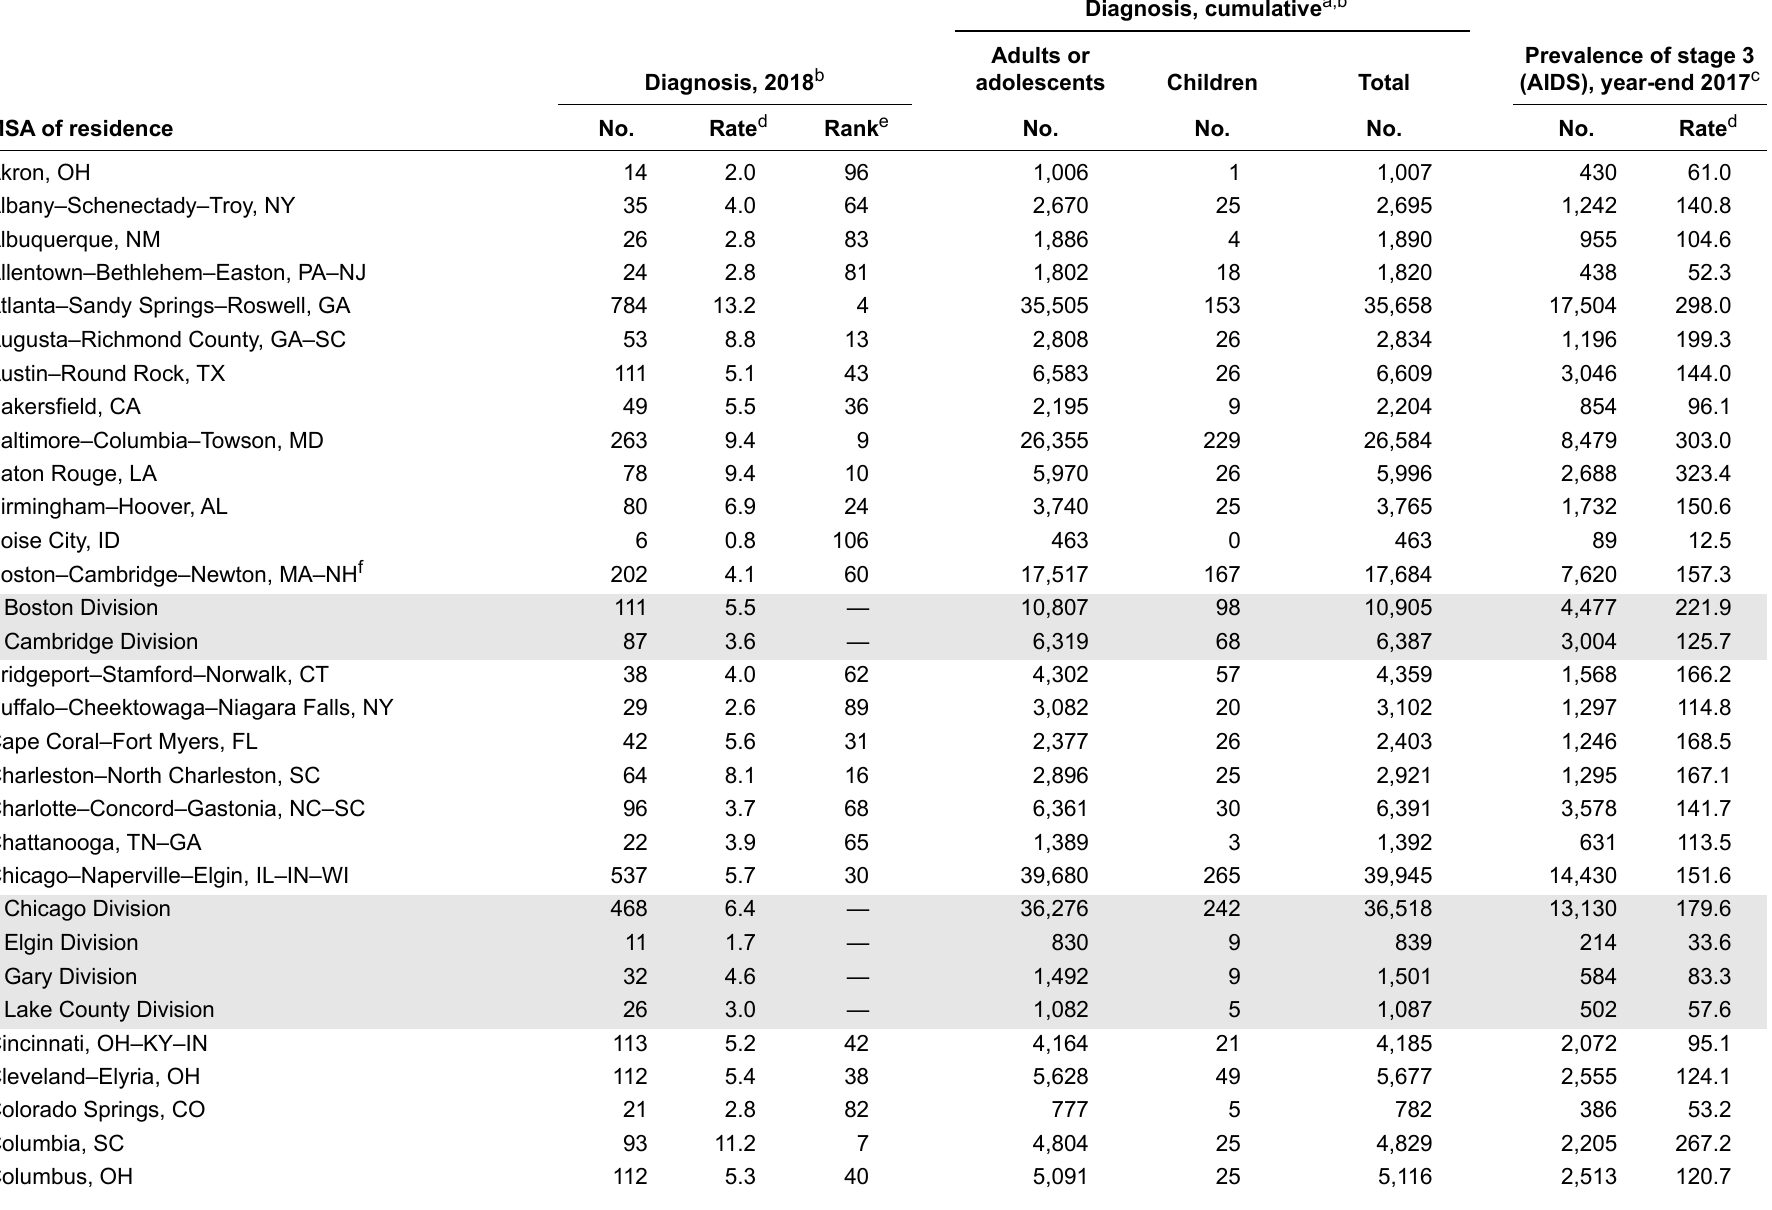
Table 31. Stage 3 (AIDS), 2018 and cumulative, and persons living with diagnosed HIV infection ever classified as stage 3 (AIDS) (prevalence), year-end 2017, by metropolitan statistical area of residence—United States and Puerto